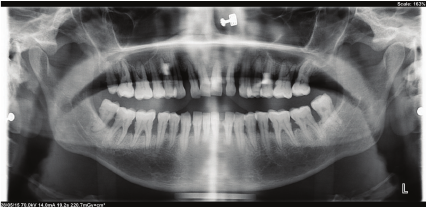
Figure 4: Orthopantomogram showing normal bone